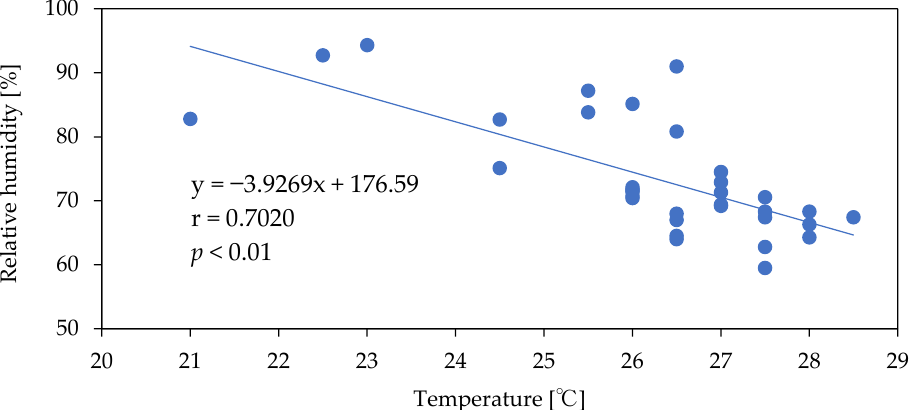
Figure 3. Relationship between median temperature and median relative humidity